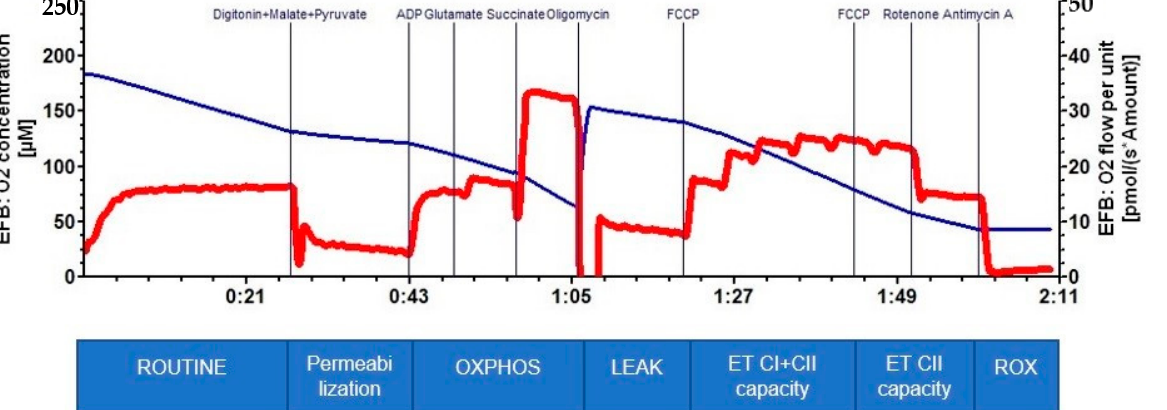
Figure 1. A representative trace of HRR in permeabilized cells (platelets) displaying the oxygen concentration in the chamber over time (blue trace) and the oxygen flux (red trace) according to the SUIT protocol. The additions are provided in the upper part of the chart. The respiratory parameters are provided in the lower part: ROUTINE respiration; OXPHOS capacity (the maximal active respiration in the presence of CI and CII substrates plus ADP); LEAK (the non-phosphorylating respiration in the presence of oligomycin); ET capacity (the maximal uncoupled respiration in the presence of FCCP); and ROX (residual oxygen consumption). See the explanations in the text above.